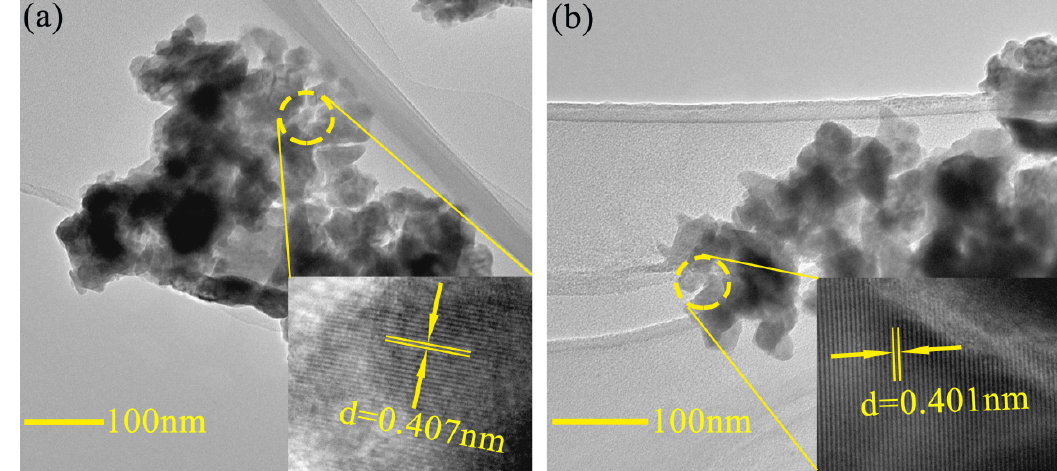
Figure 7. Typical TEM images of ( a ) BFO and ( b ) BFC 0.05 O thin film. The insets are high resolution TEM images of BFO and BFC 0.05 O thin film.